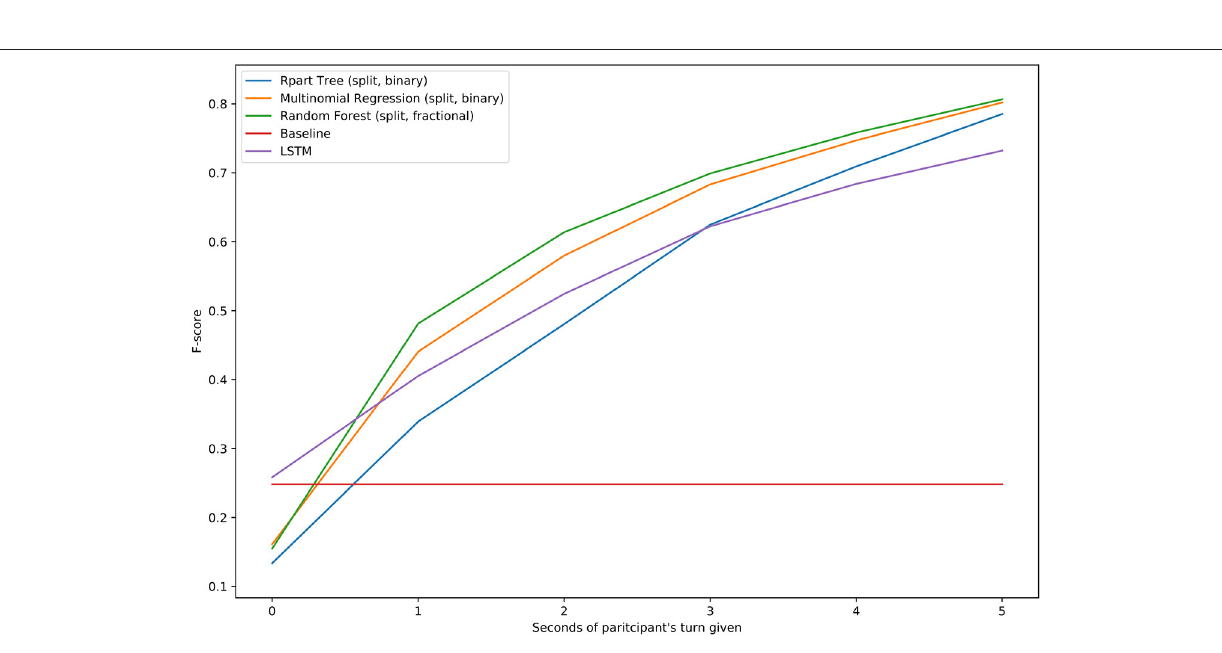
FIGURE 8 | The F-score of the various models from Table 3 when they are only given data corresponding to the first second of the participant’s turn, first 2 s of the participant’s turn, and so on until 5 s, at which point the F-scores stop going up or down, even though there are a small number of clips with a participant turn as long as 11